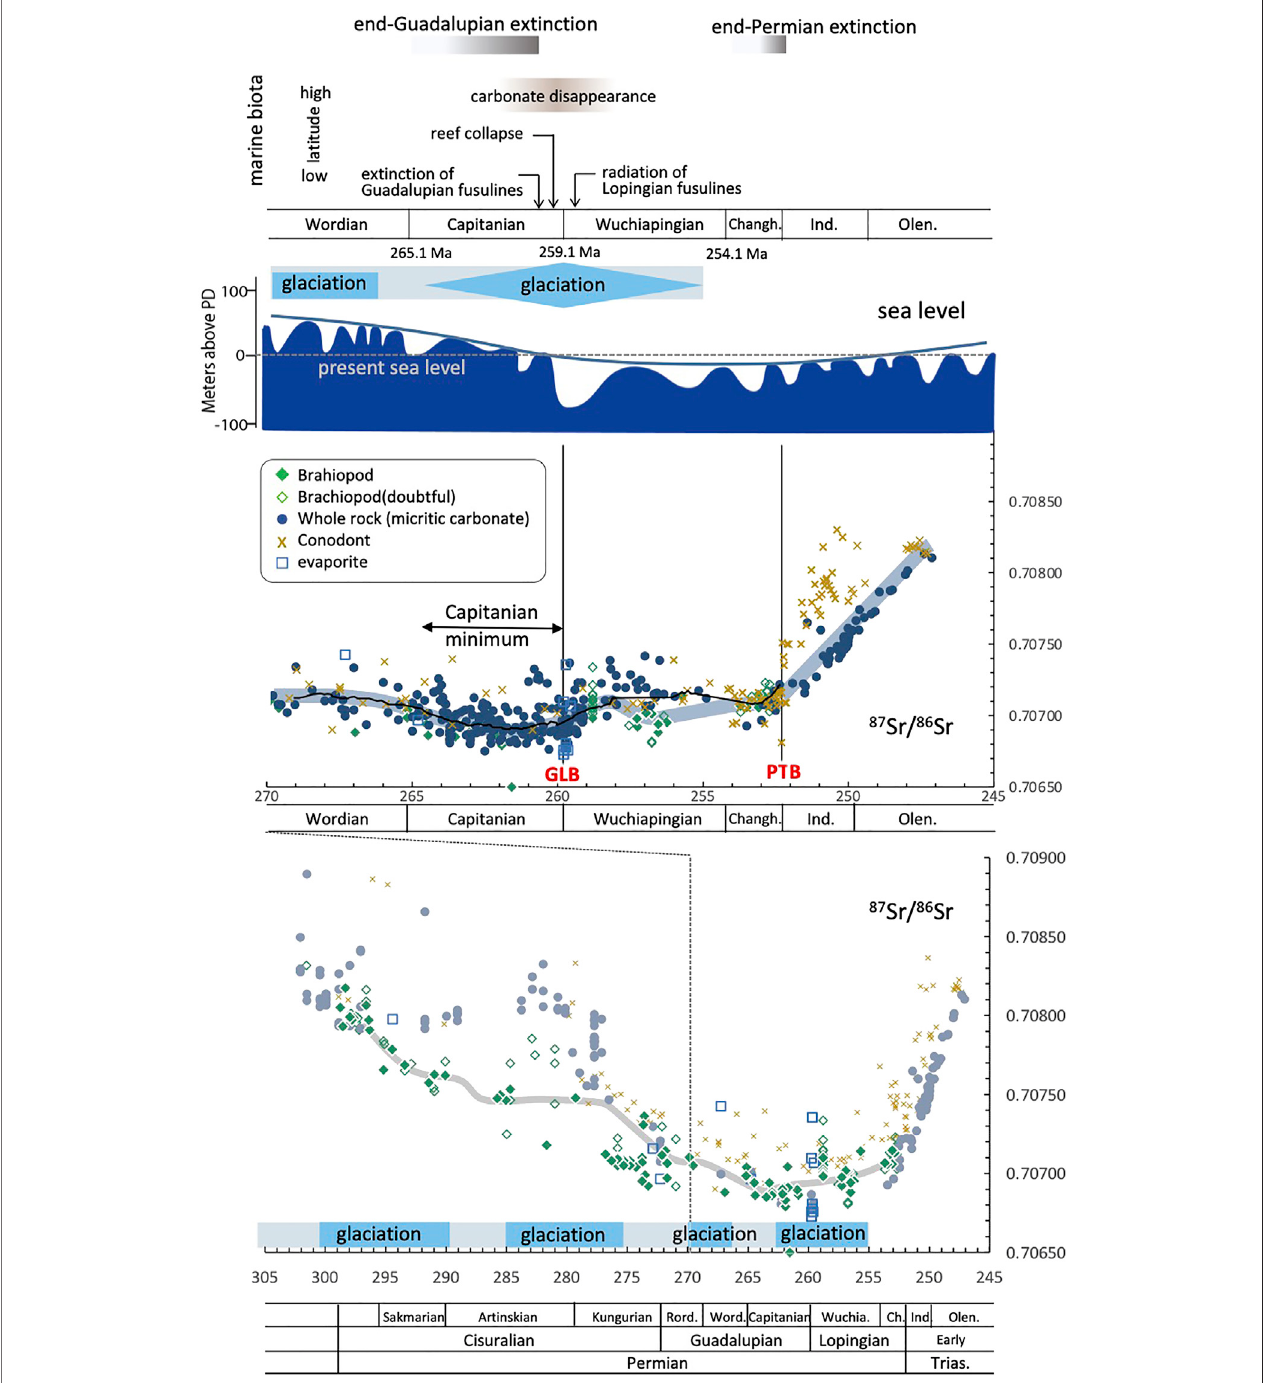
FIGURE 2 | A schematic correlation diagram showing an updated secular change in seawater Sr isotope values across the GLB, together with coeval global environmentalchanges,sea-levelchanges,andextinctions. 87 Sr/ 86 Srcurve(Upper):ValuesadoptedfromVeizerandCompston(1974),Denisonetal.(1994),Martinand Macdougall(1995),Morante(1996),Korteetal.(2003),Korteetal.(2004),Korteetal.(2006),Kanietal.(2013),Sedlacek etal.(2014),Vollstaedtetal.(2014),Songetal. (2015), Wang et al. (2018), Kani et al. (2018), Li et al. (2020), Li et al. (2021). All data were adjusted to NIST SRM 987 (cid:1) 0.710248 (McArthur et al., 2001) and recalculated according to the Geologic Time Scale 2012 (Gradstein et al., 2012). The black line is the running average of biostratigraphically well-de fi ned (conodont biozonation) and well-preserved (diagenetically screened) brachiopod and conodont and well-de fi ned (conodont or fusuline biozonation) whole rock (micritic carbonate) data with 2 m.y. time steps and a 3 m.y. window. 87 Sr/ 86 Sr curve (Lower): modi fi ed from Figure 2 in Korte and Ullmann (2016).